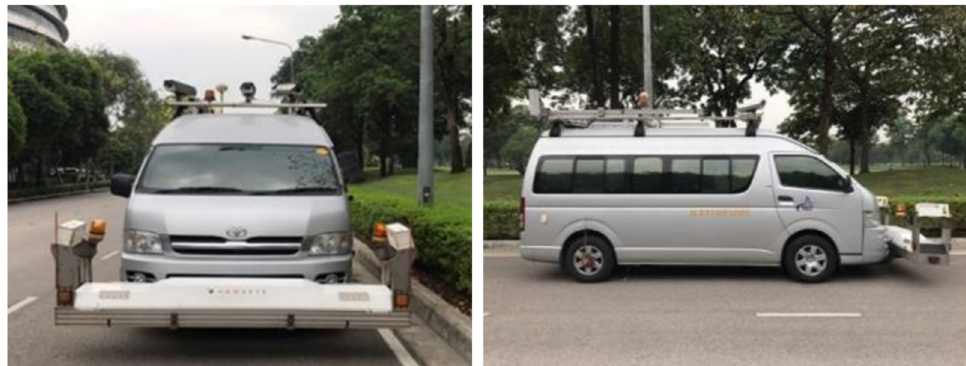
Figure 3. Profilometer attached in front of the MLS